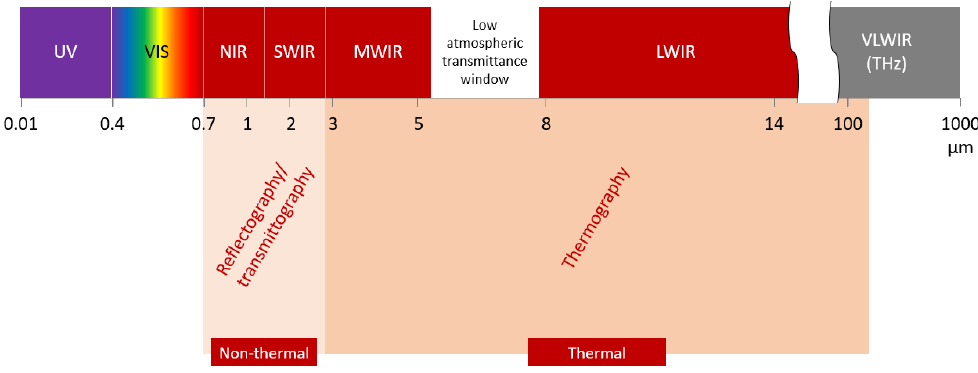
Figure 2. Infrared spectral regions. Adapted from [29].